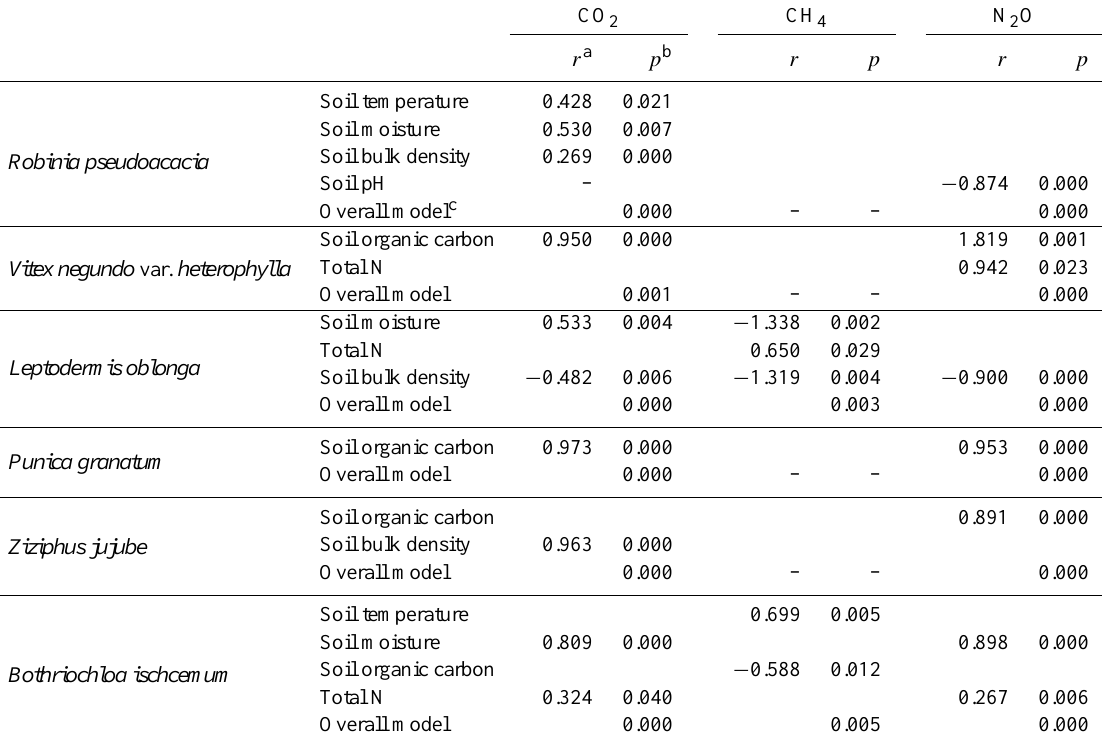
Table 6. Stepwise regressions for the relationship between soil properties and GHG fluxes.